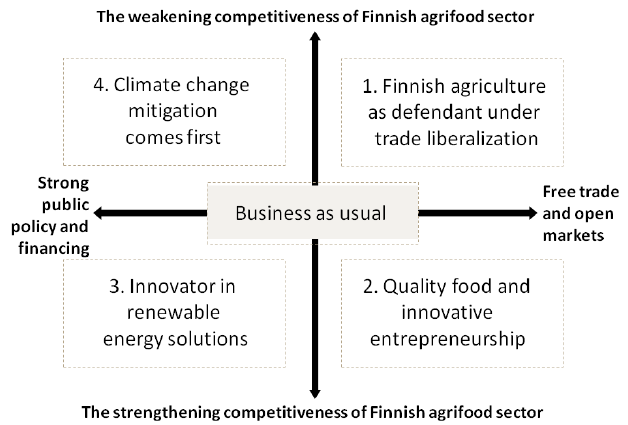
Fig. 1 . The alternative scenarios introduced to the Delphi panelists (based on Niemi and Rikkonen 2010).